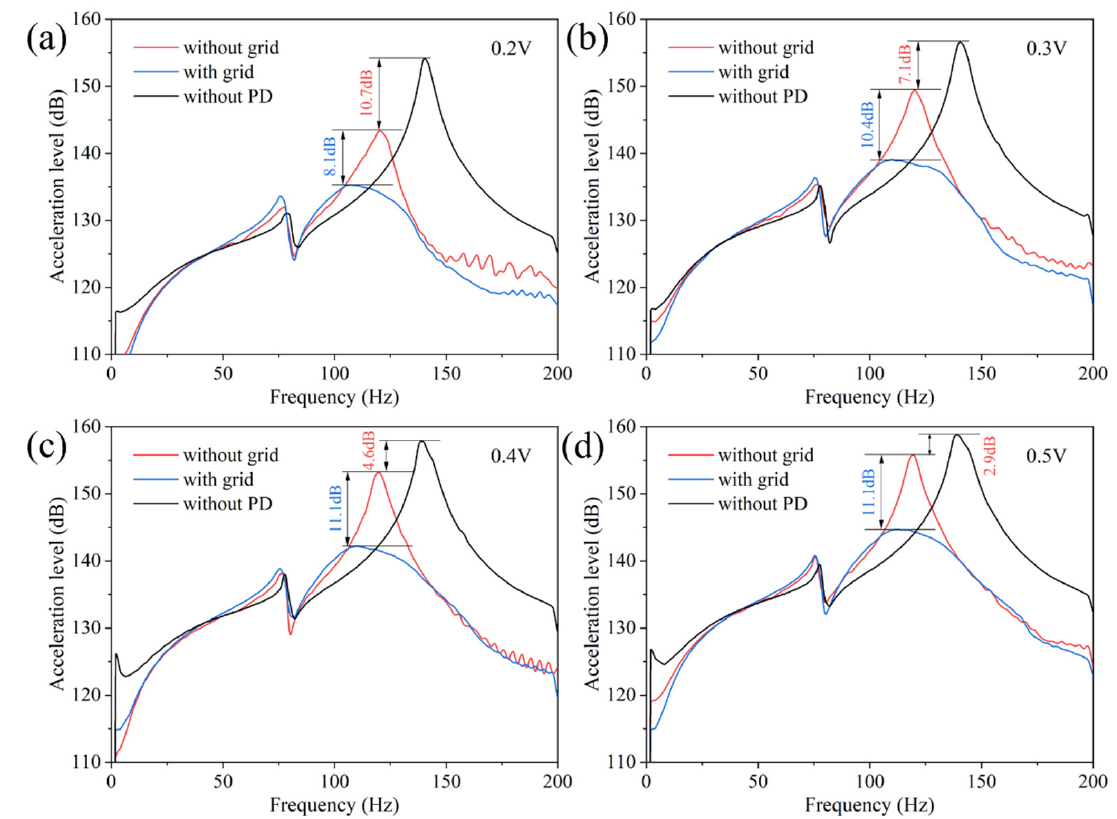
Figure 9. Vibration response of cantilever beam with and without obstacle grid particle dampers under different excitation amplitudes, excitation voltage (a) 0.2V, (b) 0.3V, (c) 0.4V, (d) 0.5V.